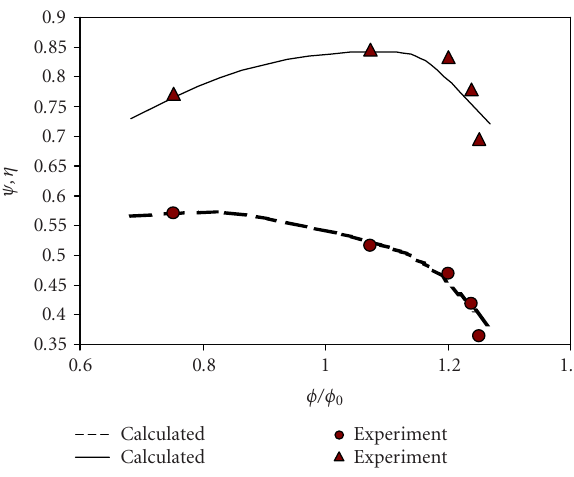
Figure 3: Calculated and measured performance characteristics, showing a good agreement between the two.